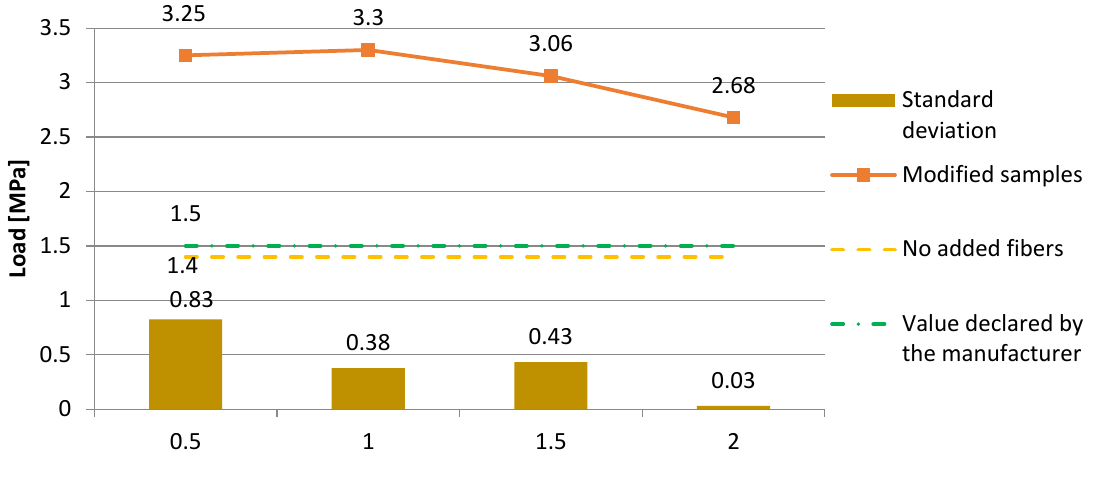
Figure 11. The dependence of the pull-off strength of the epoxy resin coating on the cement slurry substrate with regards to the amount of added fibers.